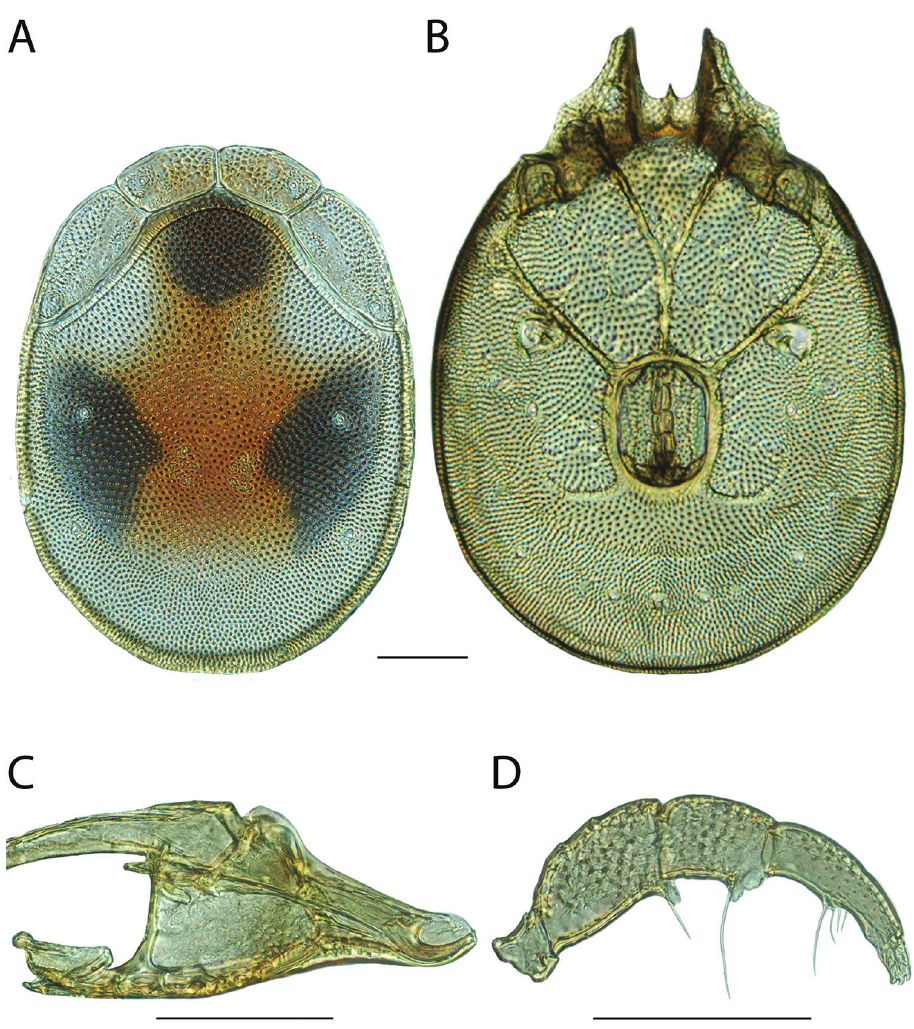
Figure 257. Torrenticola trimaculata male: A dorsal plates B venter (legs removed) C subcapitulum D pedipalp (setae not accurately depicted). Scale = 100